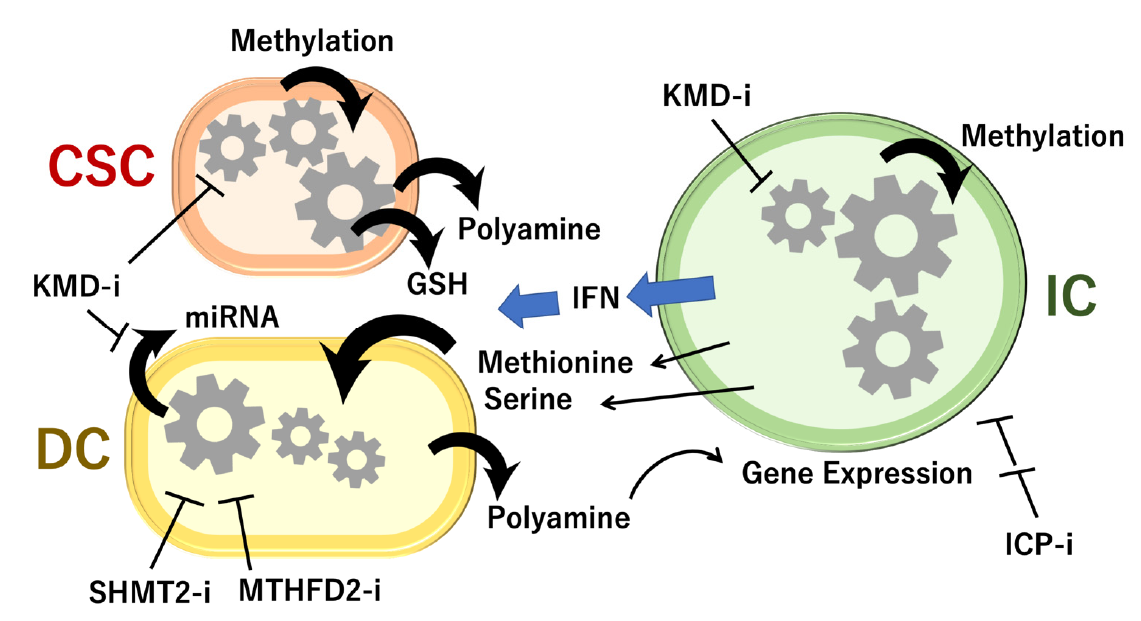
Figure 4. Cell-to-cell interaction of 1C metabolism. GSH, glutathione; SHMT2-i, inhibitor to serine hydroxymethyltransferase 2; MTHFD2-i, inhibitor to mitochondrial bifunctional methylenetetrahydrofolate dehydrogenase/cyclohydrolase; KDM-i, inhibitor to lysine demethylase; IFN, interferon; CSC, cancer stem cell; DC, daughter cancer cell; IC, immune cell. Drug discovery within 1C metabolism pathways may give rise to targets for cancer therapeutics [3,32].